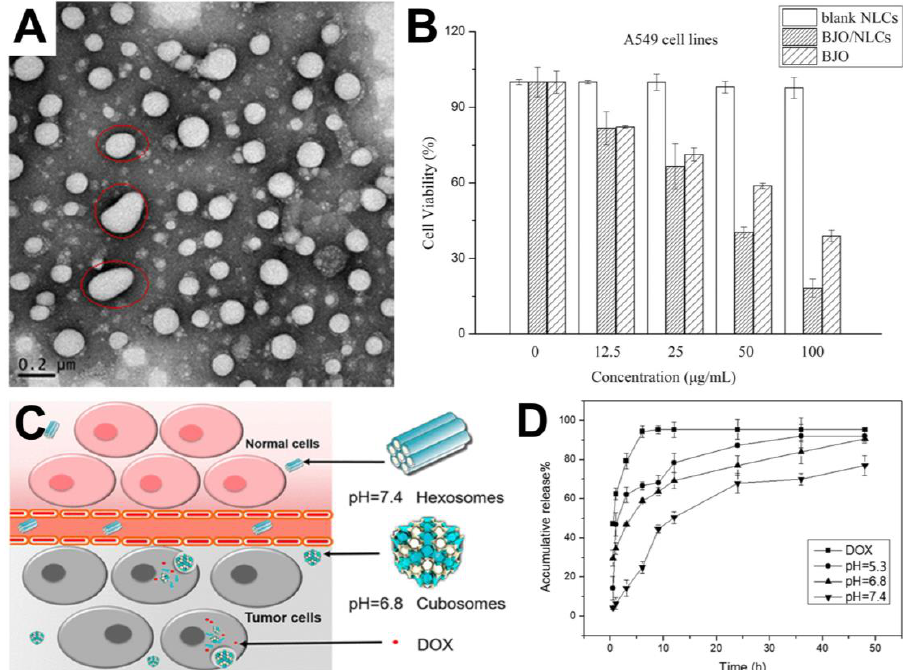
Figure 5. ( A ) Transmission electron microscopy (TEM) image of nanostructured lipid carrier (NLC)-encapsulated Brucea javanica oil (BJO) in phosphate-buffered saline (PBS) (pH 7.4). Red circles indicate representative NLC particles with spherical or elongated shapes; ( B ) Effects of blank NLCs as well as free and NLC-encapsulated BJO on the viability of human lung cancer cells after 48 h of incubation. Reproduced with permission from [75]. ( C ) Schematic illustration of pH-dependent changes in the